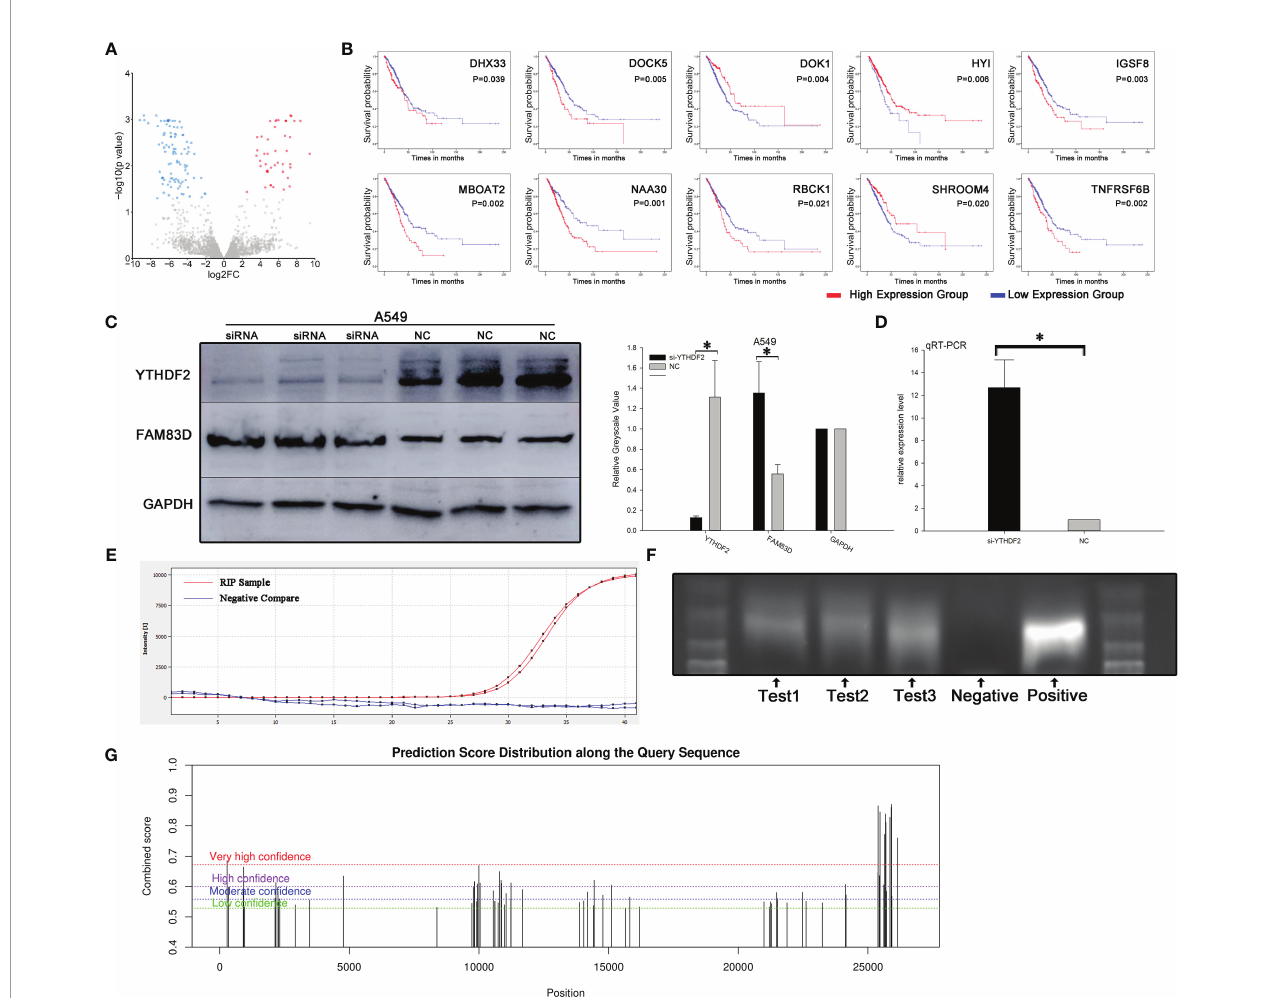
FIGURE 3 | FAM83D was one of the molecules downstream of YTHDF2. (A) Volcano map of proteins in pathways downstream of YTHDF2. (B) Expression of eleven survival-related proteins in pathways downstream of YTHDF2 in lung adenocarcinoma. (C) FAM83D protein expression level after YTHDF2 knockdown, as measured using WB. (D) FAM83D mRNA levels after YTHDF2 knockdown, as measured using qRT – PCR. (E) RIP assay showing that the FAM83D mRNA was enriched by YTHDF2 antibody-bound magnetic beads, and actin was used as a negative control. (F) Bands of three independent RIP assays analysed using DNA agarose gel electrophoresis. (G) Prediction of m6A binding sites in FAM83D mRNA. *Statistical difference (P <